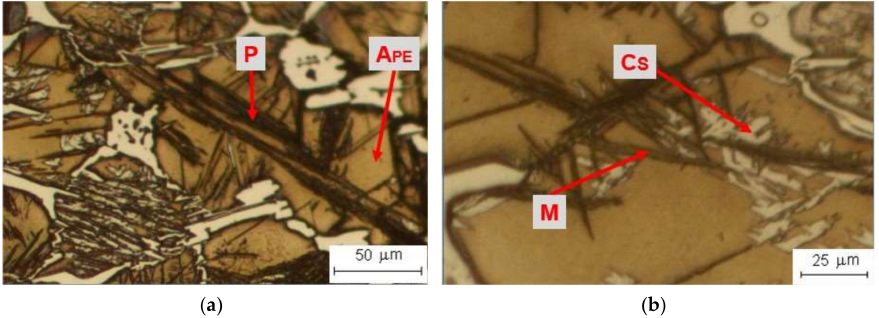
Figure 5. Attack 4 (Marshall reagent for 60 s at room temperature, 5% ammonium persulfate at room temperature) + Kalling N ◦ 1: ( a ) general view at 200 × ; ( b ) detail at 500 ×